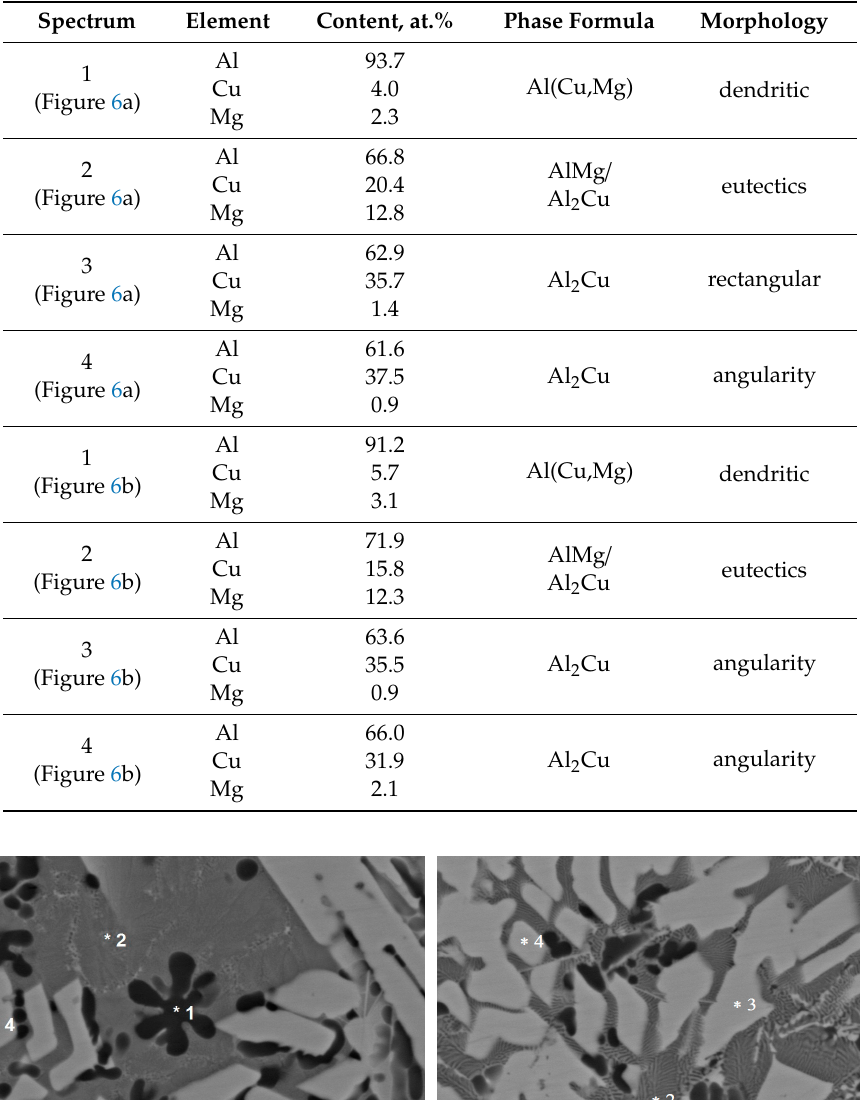
Table 3. Chemical compositions of phases shown in Figure 6.